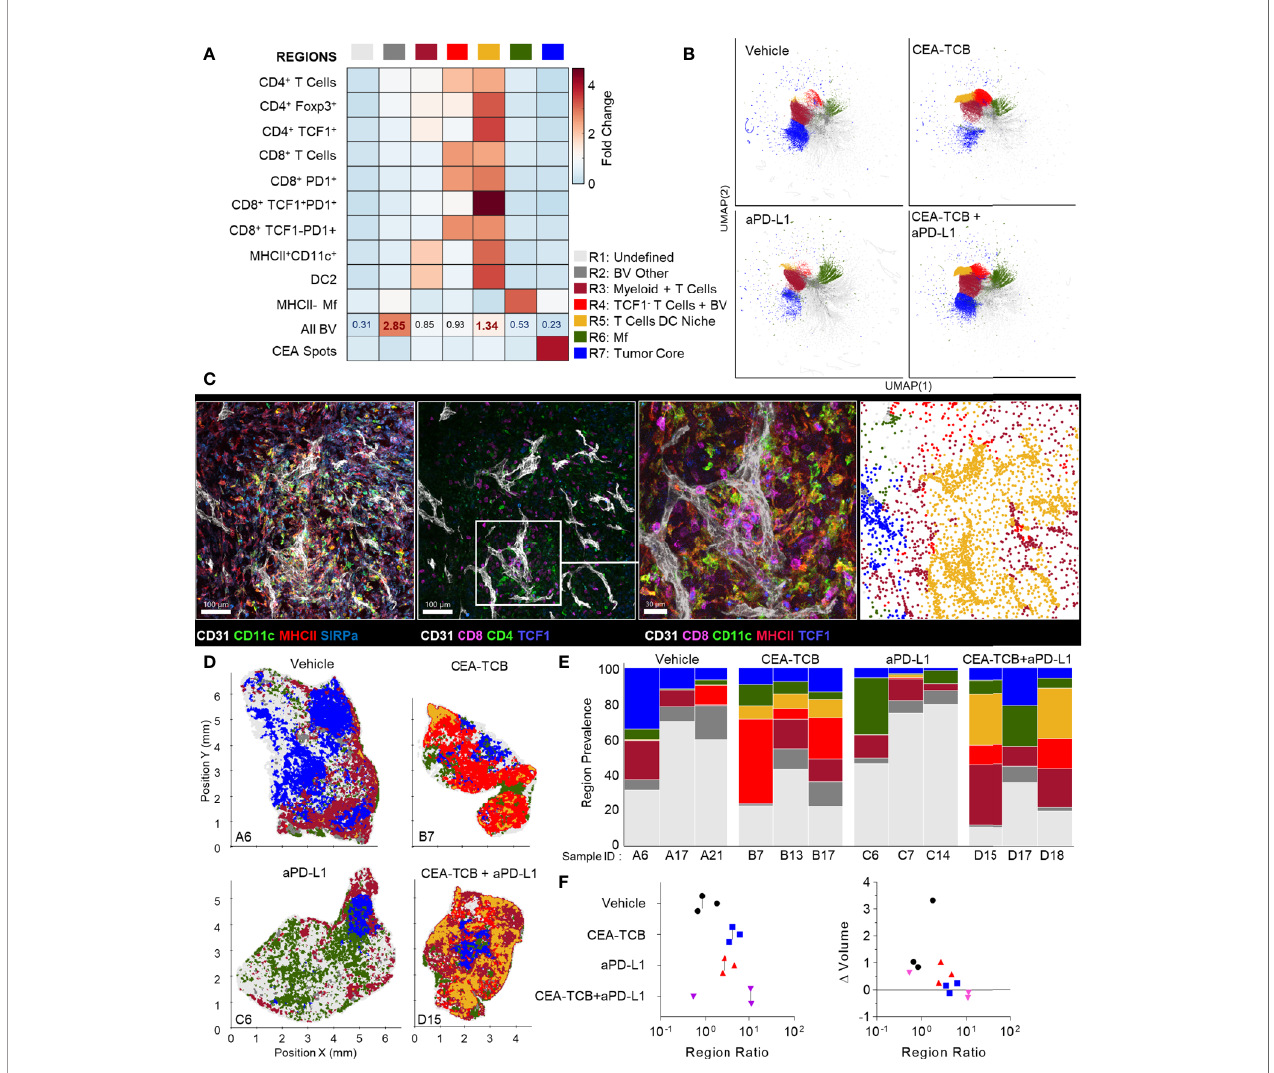
FIGURE 6 | CytoMAP based regional analysis of the KPC-CEA tumor microenvironment. (A) Neighborhoods were clustered into regions and plotted on a region heatmap. Plot displays fold change of the object density per neighborhood within each region across all samples. (B) UMAP plots of the color-coded neighborhoods from each treatment group showing heterogeneity in the tissue regions. (C) Region of interest (ROI) from multiplexed confocal image showing association of the T cells and DCs with BVs. Scale bar represents 100 µm (two left images) and 30 µm (third image). The rightmost plot shows the positions of cells in the same ROI color-coded by the region classi fi cation de fi ned in panel (A, D) Positional plots of all neighborhoods for select samples from each treatment group, color-coded by region classi fi cation de fi ned in panel (A, E) Region prevalence for each sample (columns) within the four treatment groups. (F) Ratio of immune in fi ltrated regions to immune excluded regions (left). Ratio from F, plotted versus the fold change in tumor volume after initiation of therapy (right). All the above plots were generated from samples collected at d25, n=3 per